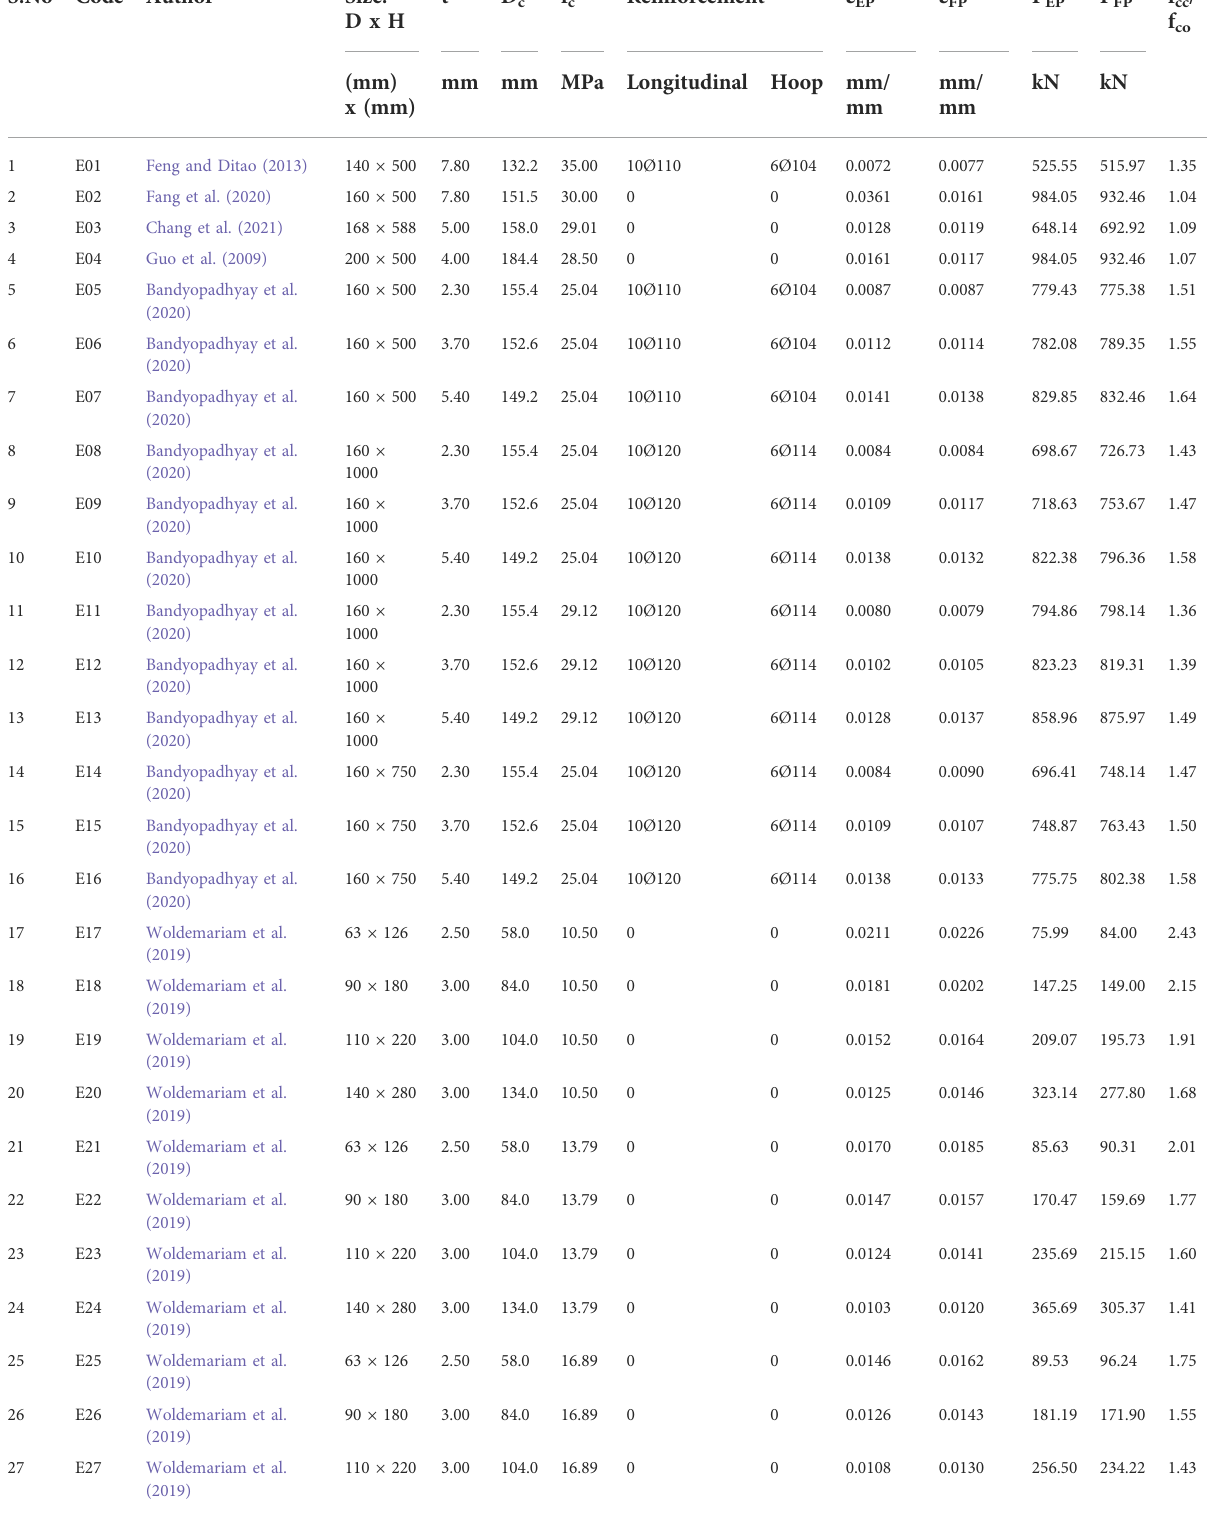
TABLE 1 Summary of Con fi ned Concrete Filled PVC Tube used in this